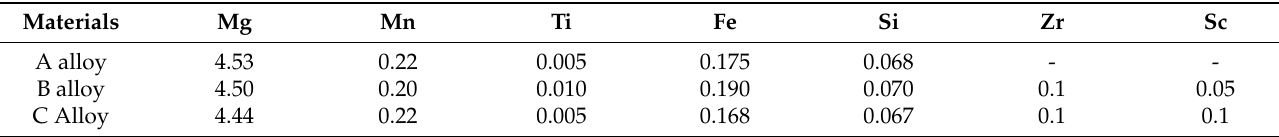
Table 1. Chemical composition of as-cast samples